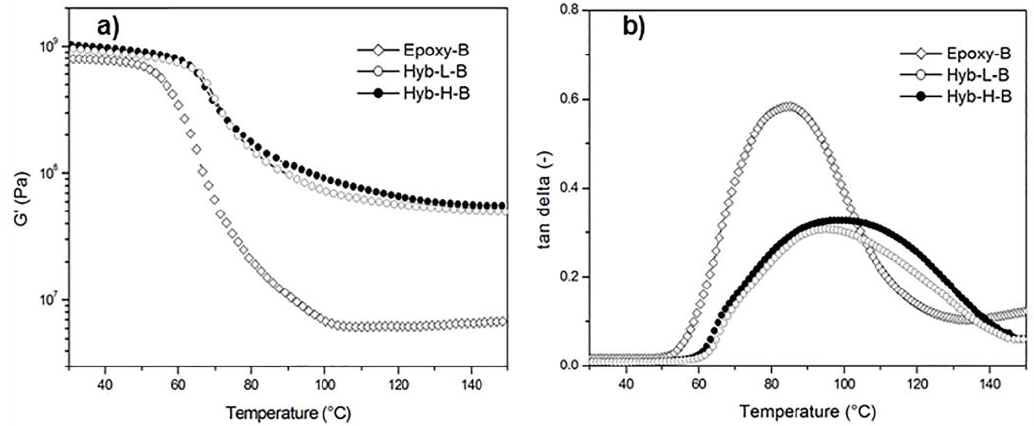
Figure 13. DMTA spectra: (a) Storage Modulus and b) tan delta of neat epoxy resin and of the O-I hybrids based on the same resins, all cured with the cycloaliphatic amine.